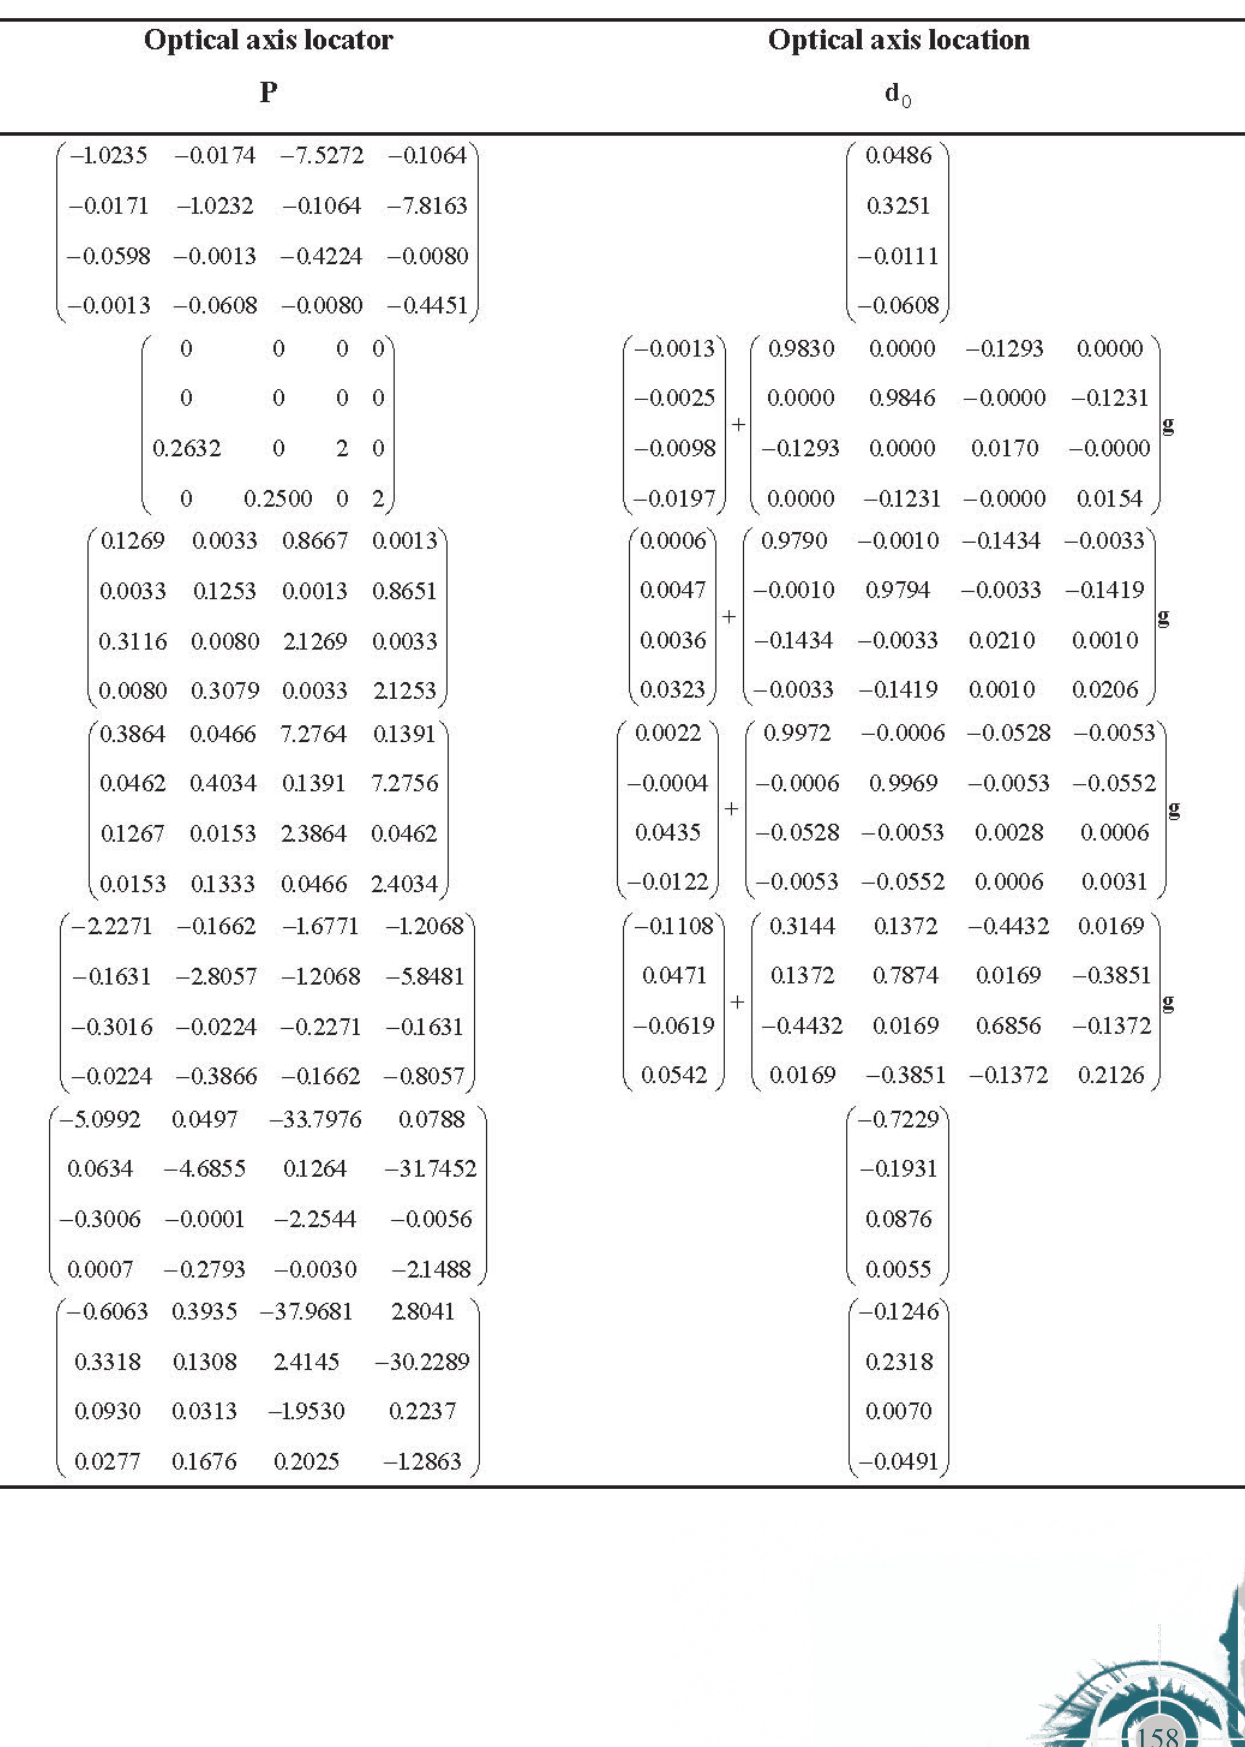
Table 1 The locator P for and location d The entries in the top-right 22 × block of P and the top two entries of d P are in